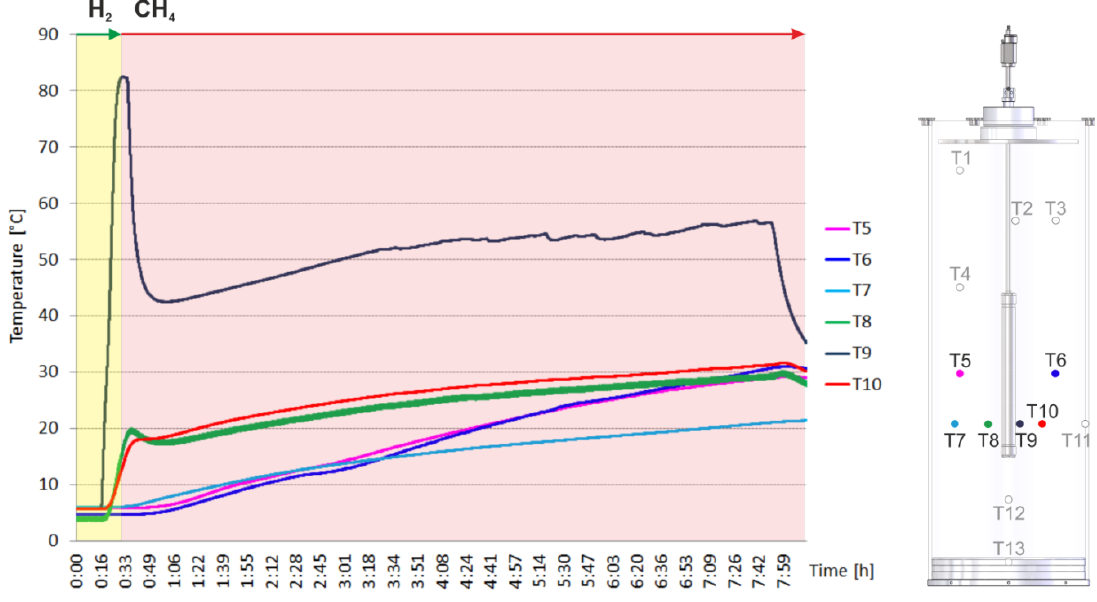
Figure 6. Left: Temperature profiles versus time for production experiments using the reactor in sediment + water + hydrate (80%) without external cooling. Right: Positions of the temperature sensors within LARS, empty circles show positions of temperature sensors whose profiles are not shown in the